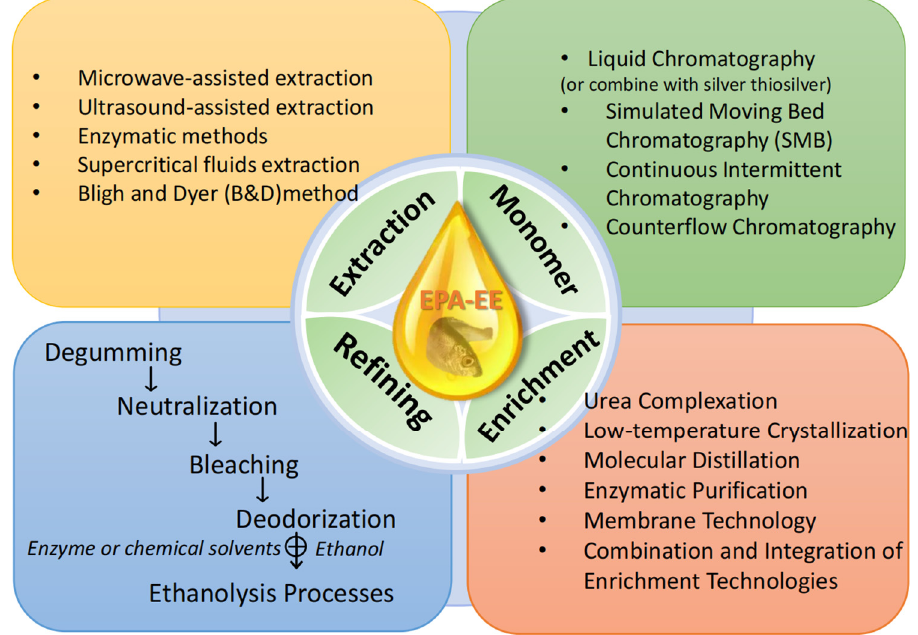
Figure 1. An overview of the main processing steps and the latest technology in the EPA-EE forma- tion process.